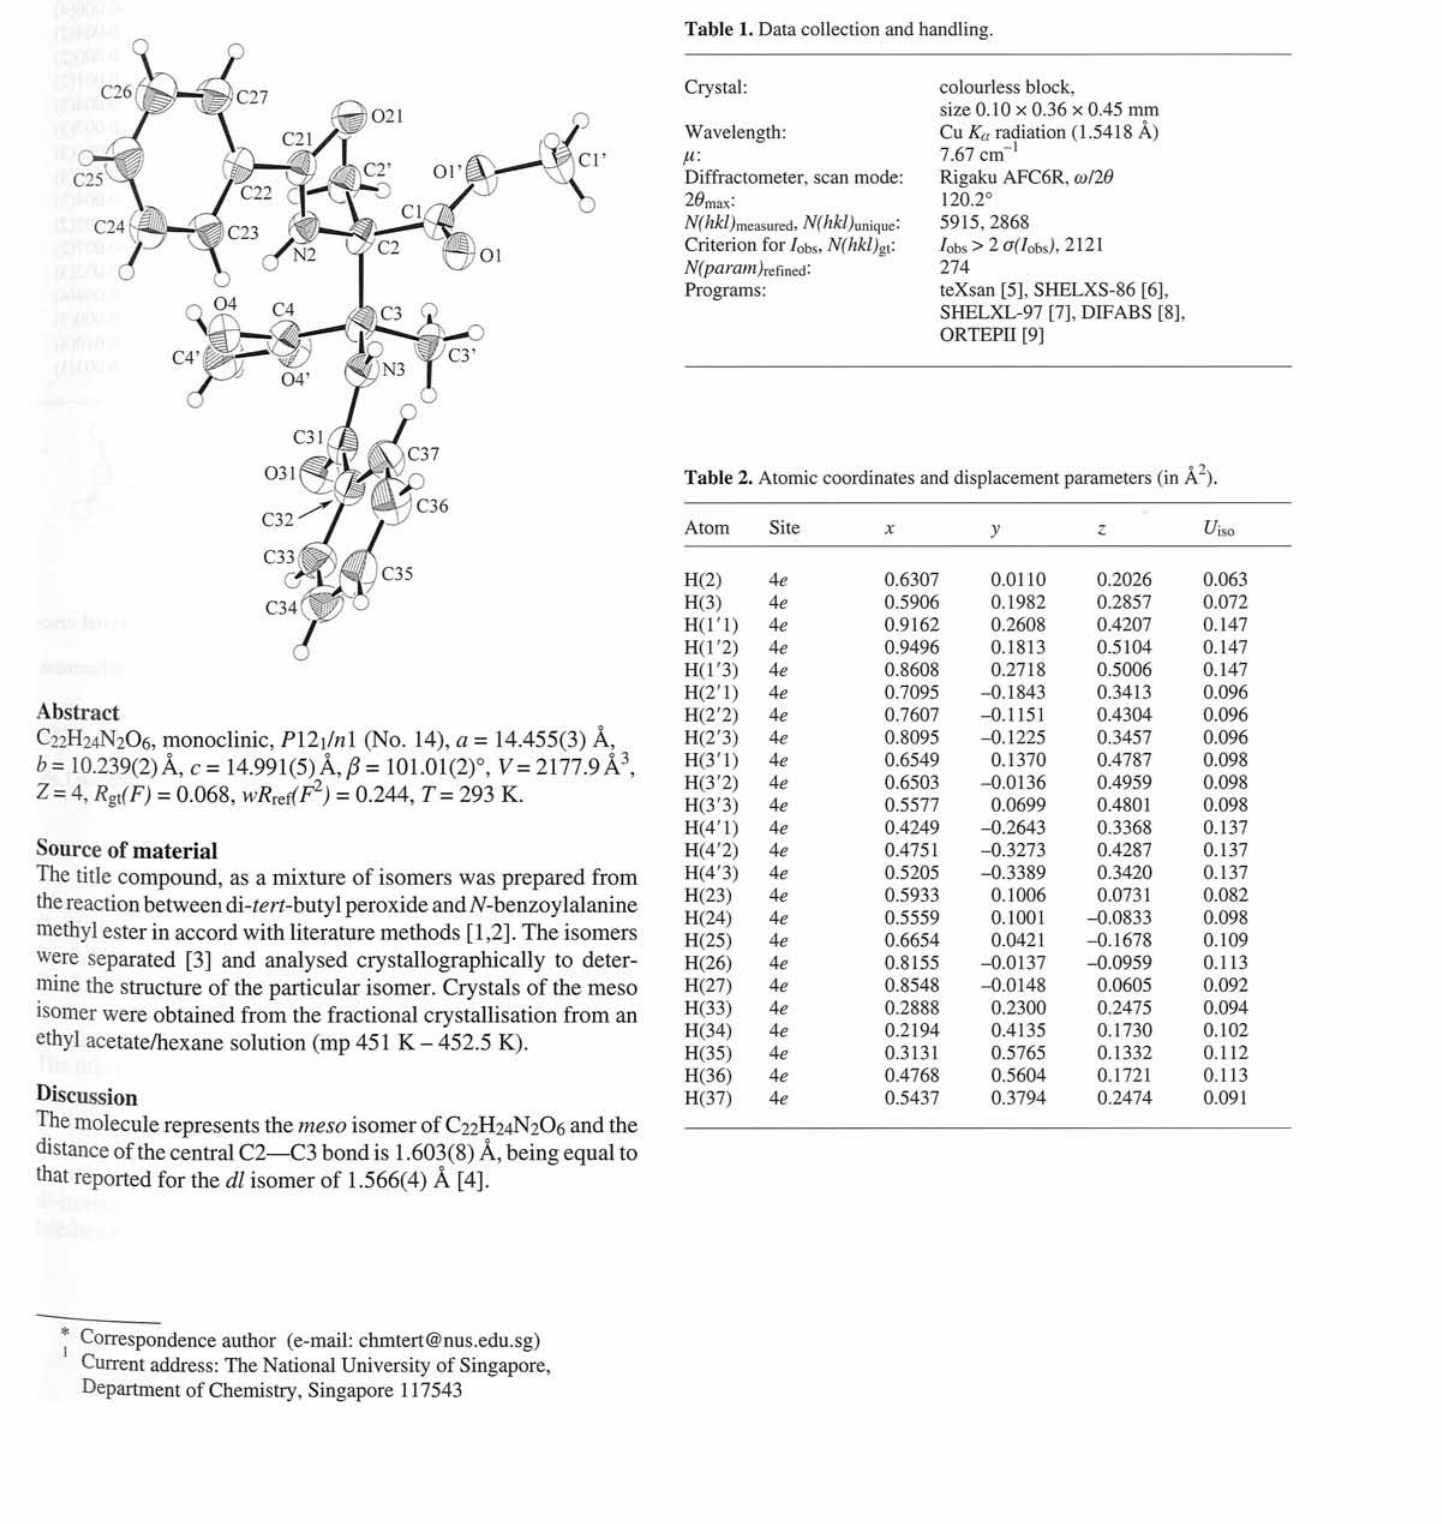
Table 1. Data collection and handling.